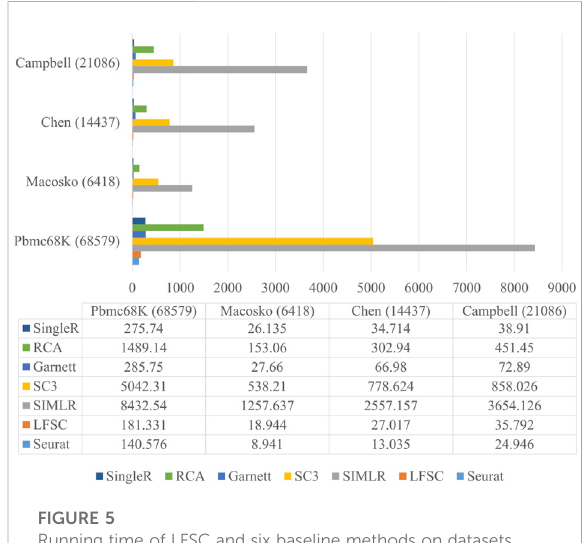
FIGURE 5 Running time of LFSC and six baseline methods on